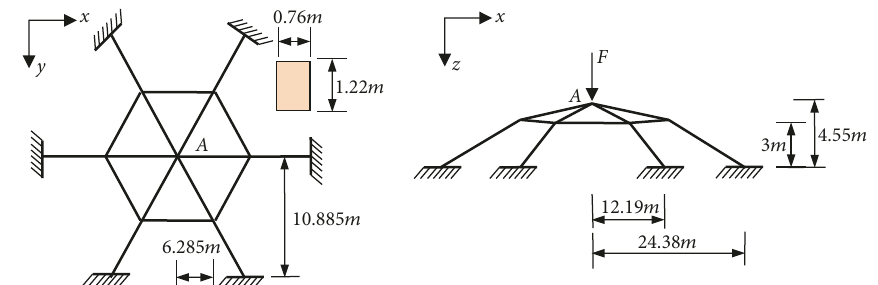
Figure 13: Spatial elastic framed dome.